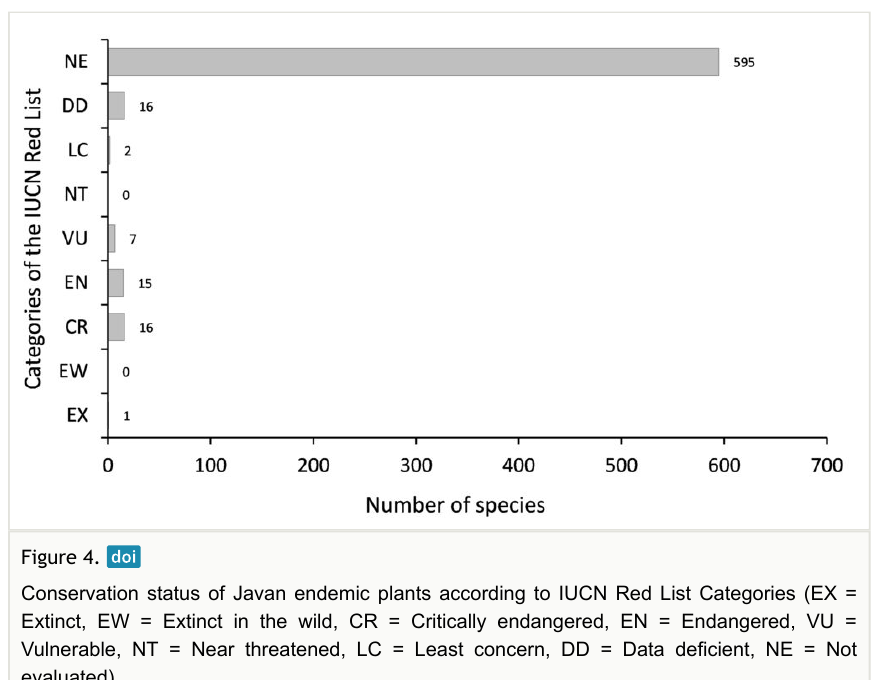
Conservation status of Javan endemic plants according to IUCN Red List Categories (EX = Extinct, EW = Extinct in the wild, CR = Critically endangered, EN = Endangered, VU = Vulnerable, NT = Near threatened, LC = Least concern, DD = Data deficient, NE = Not